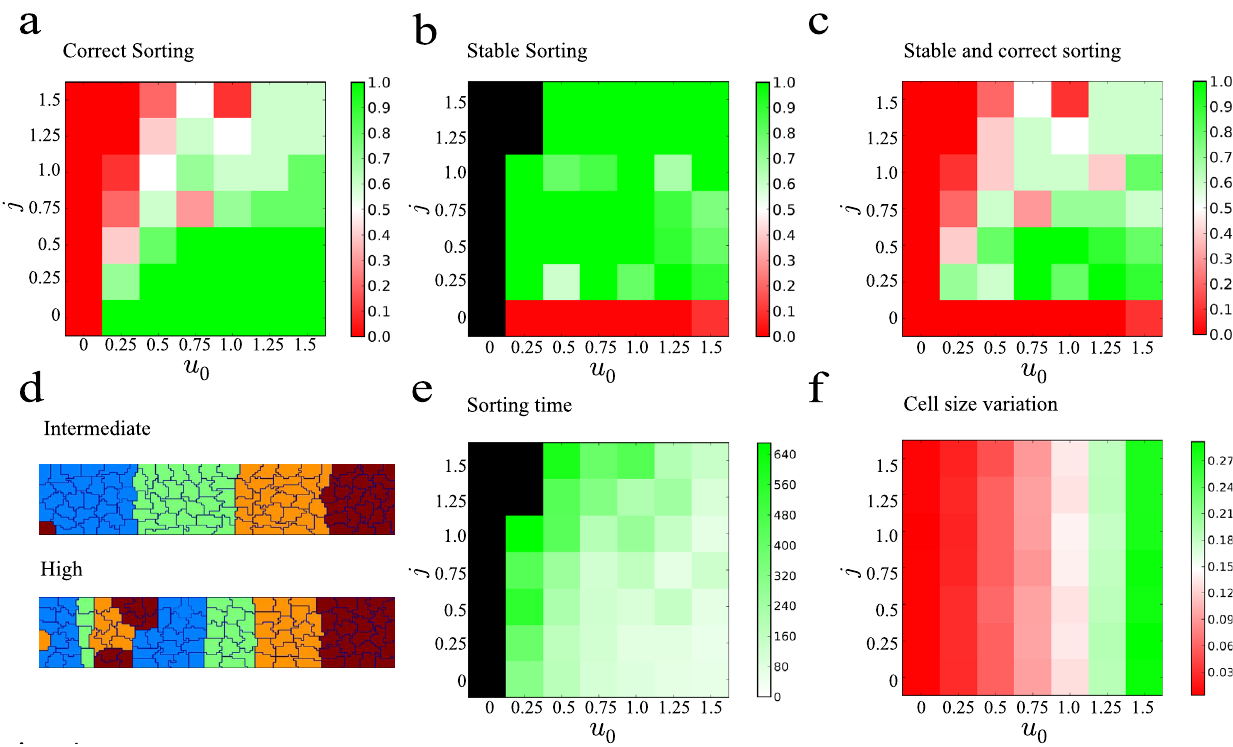
Figure 4. Intermediate levels of magnitudes of chemotactic response, m o , and differential adhesion, j , lead to correct and stable sorting with low cell size variations. 10 runs were performed for each value of m o and j . ( a – c ) Fraction of correct sorting, F c (a), stable sorting, F s (b) and fraction of runs that lead to both correct and stable sorting (c) for different combinations of m o and j . ( d ) Cell grid obtained for intermediate (top) and high j (last). For intermediate j , a few cells are sorted incorrectly. At high j , a larger number of cells are mis-sorted. These mis-sorted cells formed stable clusters with cells of the same fate. ( e ) Sorting time, t s , for different combinations of m o and j . (Combinations of m o and j with F c = 0 are shown in black) ( b ) Cell size variation for different combinations of m o and j . Size variation increases with m o but does not depend on j